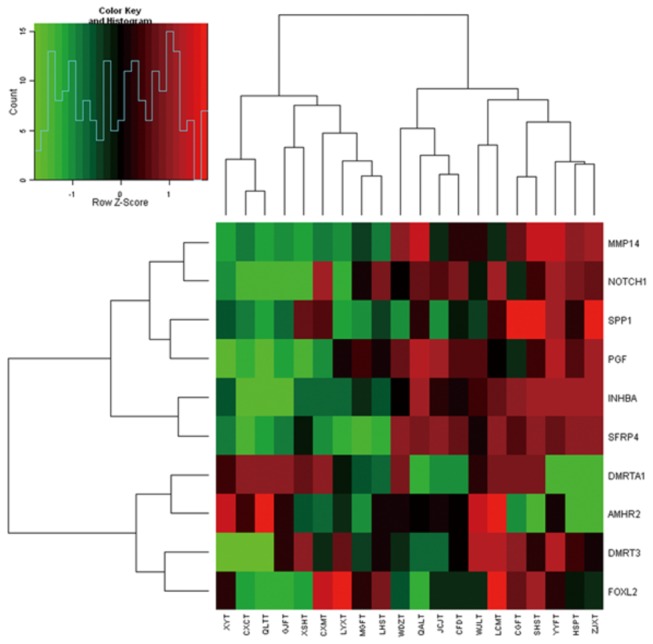
Expression data matrix of reproduction associated genes from tumors of 20 gastric cancer patients hybridized using the custom microarray.The expressions of genes between two groups have significant differences, fold change log2 >=1 or <= -1, P<0.01.